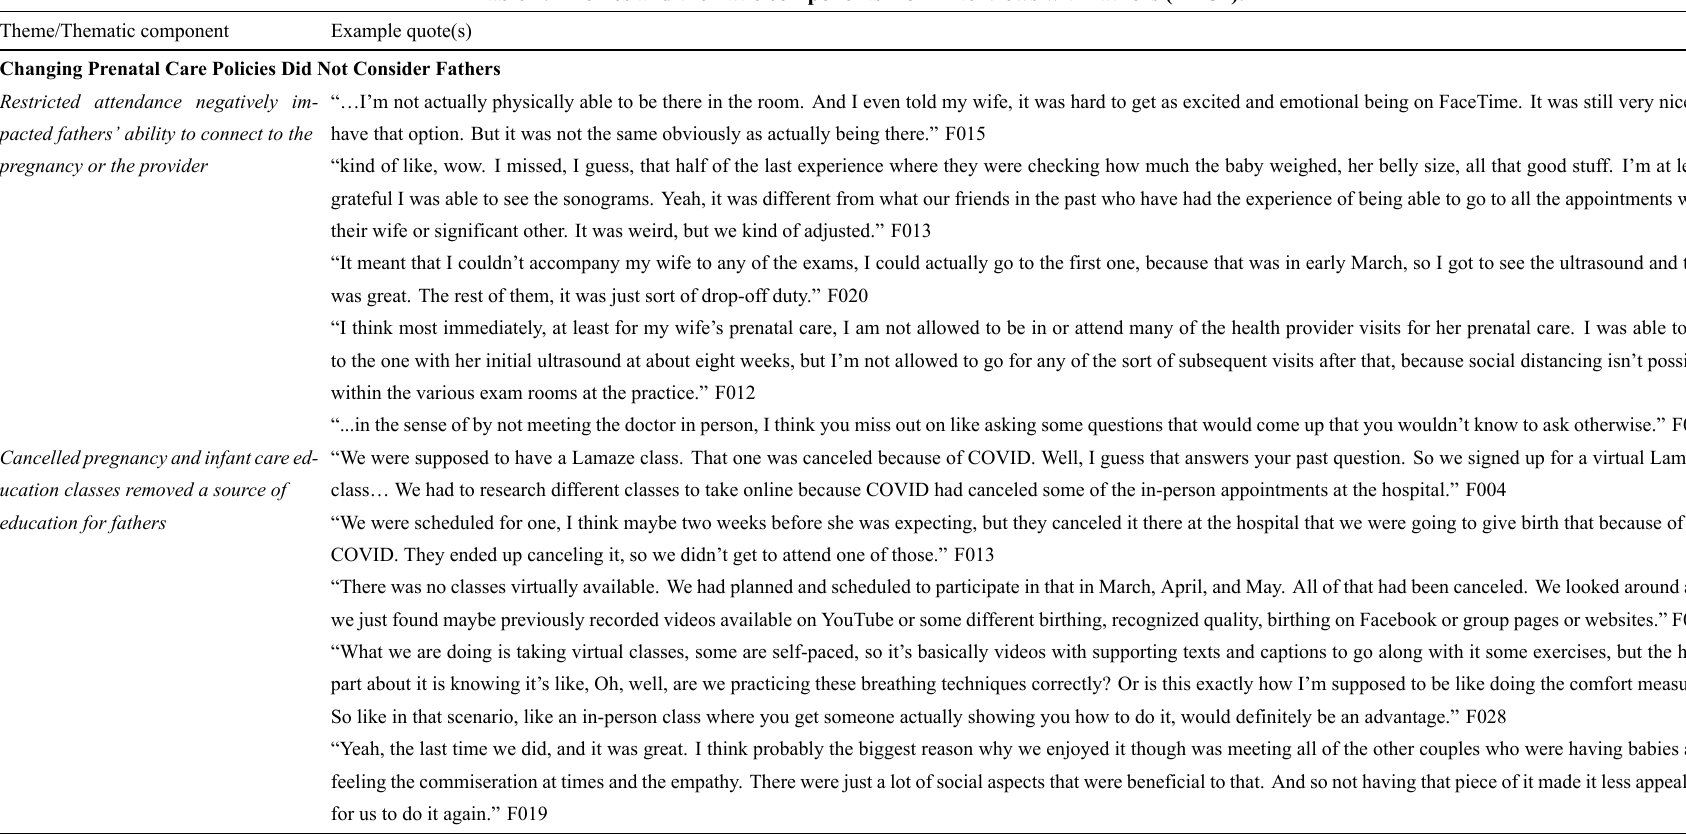
Table 1. Themes and thematic components from interviews with fathers (n =